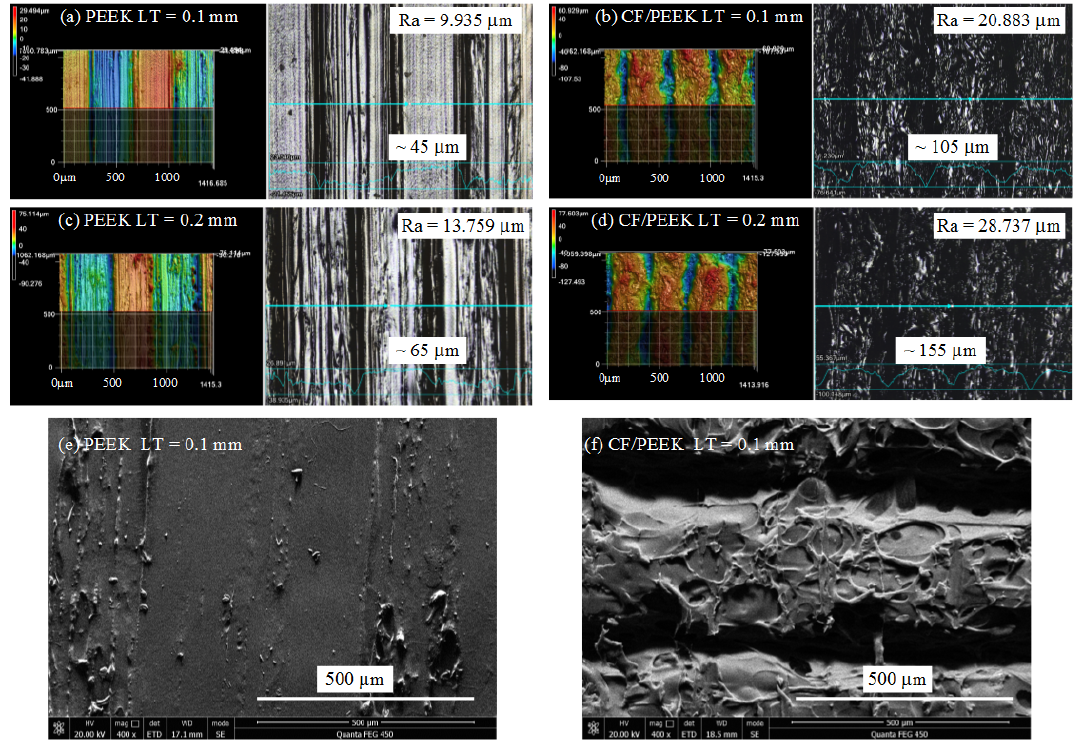
Figure 3. Superficial surfaces of the 3D-printed samples: ( a ) 3D morphology of the PEEK part with LT of 0.1 mm; ( b ) 3D morphology of the CF/PEEK part with LT of 0.1 mm; ( c ) 3D morphology of the PEEK part with LT of 0.2 mm; ( d ) 3D morphology of the CF/PEEK part with LT of 0.2 mm; ( e ) SEM picture of the PEEK part with LT of 0.1 mm; ( f ) SEM picture of the CF/PEEK part with LT of 0.1 mm.